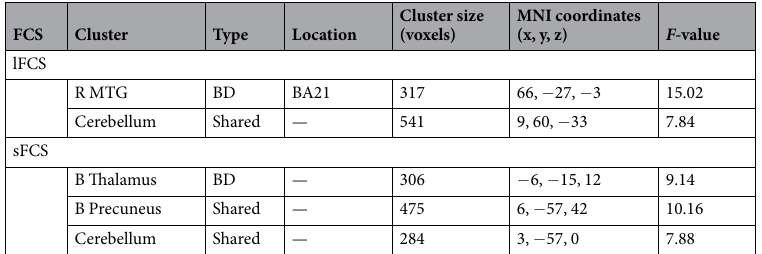
Table 2. Brain clusters showing significant group effect in the FCS ( p < 0.001 Alphasim corrected, ANCOVA). The ‘BD’ type indicates that the FCS in the cluster was altered specifically in the BD patients but not in the MDD patients. The ‘shared’ type indicates that the cluster with altered FCS was detected in both the BD and the MDD patients. Abbreviations: lFCS (sFCS), long-range (short-range) functional connectivity strength; BD (MDD), bipolar (major depressive) disorder; MTG, middle temporal gyrus; B (R), bilateral (right).